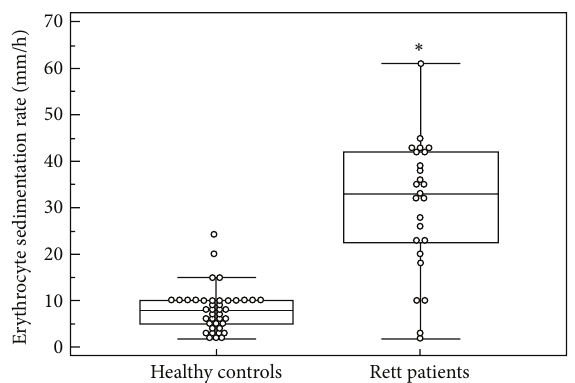
Figure 1: Erythrocyte sedimentation rate (ESR) measurements by TEST 1 in healthy controls and RTT patients. ∗ 𝑃 < 0.001